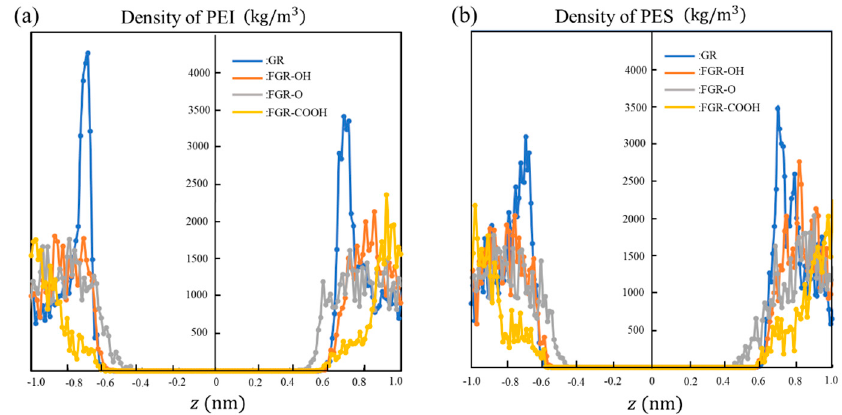
Figure 8. Density profiles of atoms in ( a ) PEI and ( b ) PES for composite models with different graphene oxides. The horizontal axis represents the position of the z-axis, which is perpendicular to the graphene interface.